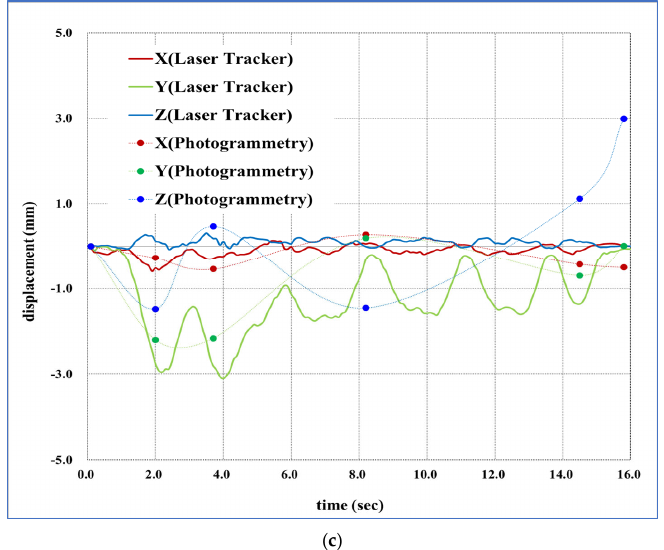
Figure 8. Displacement results of a reflector position in 3D directions by the laser tracker and the proposed method. ( a ) First train; ( b ) second train; ( c ) third train. This study also extracted and compared only the same time ‐ step points among the laser tracker measurements as the proposed method’s measurements, as shown in Figure 9. In the Y direction, the deformation shapes are substantially similar between the pro ‐ posed method and laser tracker results, while it is slightly different in the X direction. Specifically, it shows a relatively large error in the Z direction. These causes are the low performance of the camera including the calibrated IOPs, target matching errors of feature points on the bridge surface used to determine ROPs, and incomplete time synchroniza ‐ tion, even though stereo images from both cameras were taken simultaneously by a re ‐ mote control. Nevertheless, it was observed that the displacement forms of the proposed method are similar to the results of the laser tracker in the X ‐ and ‐ Z axes enlarged to a 0.1 mm scale. Therefore, it seems to be the case that the displacement values of the proposed method are exaggerated because the real size of one pixel is about 1 mm, and the ROPs scale error is caused through the photogrammetric process as mentioned above, but the displacement directivity is relatively accurate.